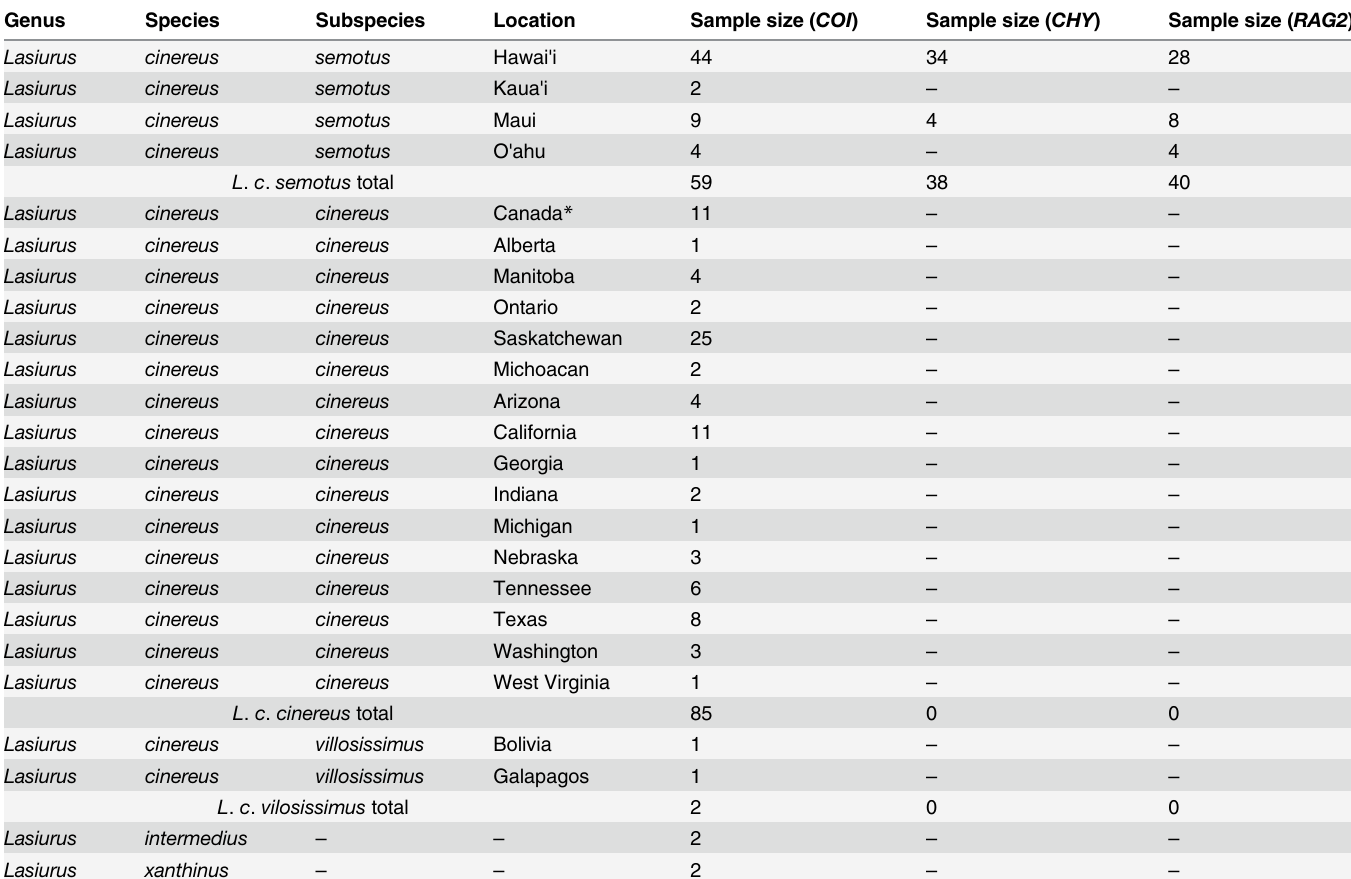
Table 1. Sampling